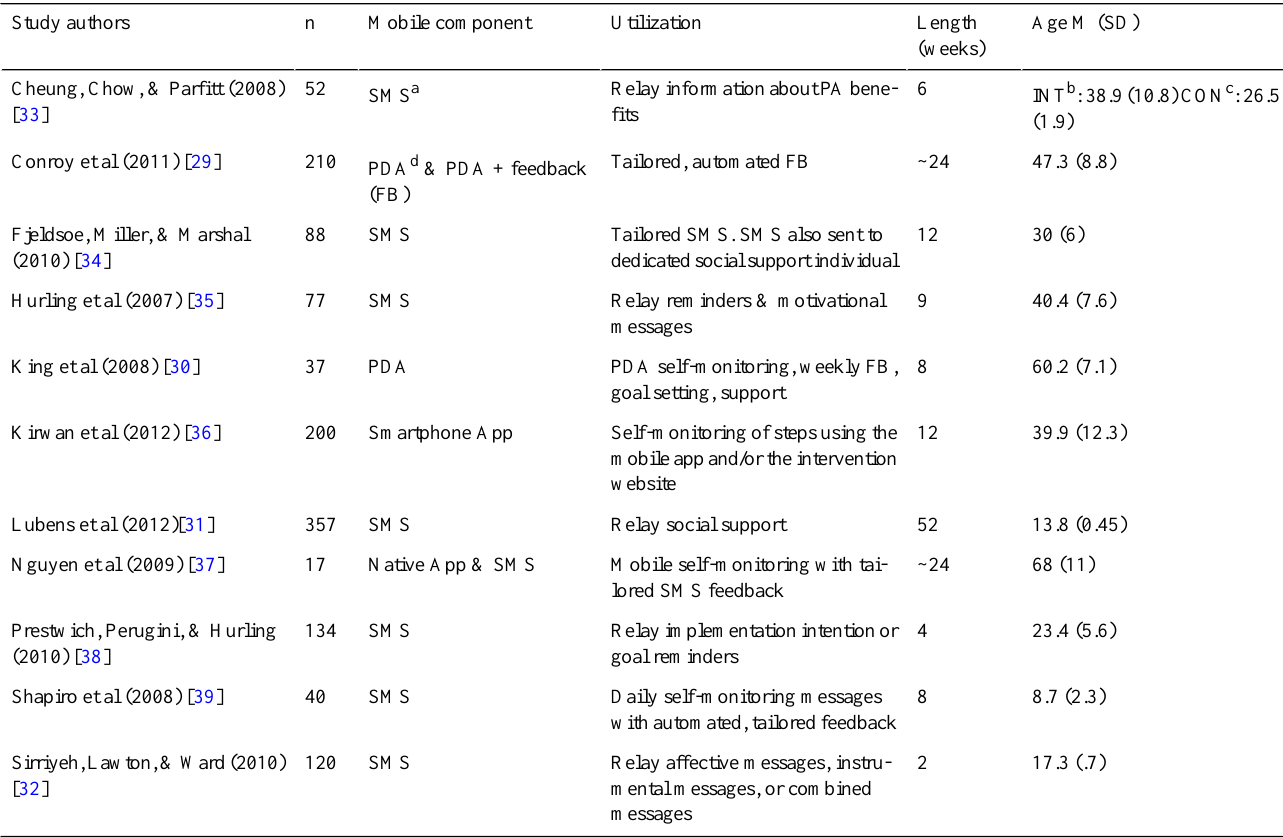
Table 1. Intervention